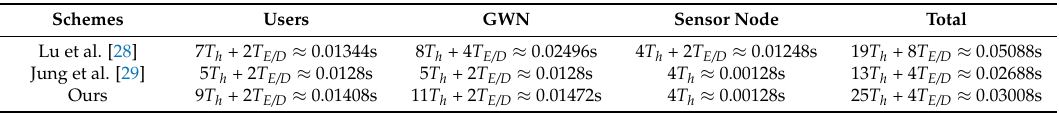
Table 3. Computation complexity comparisons of our scheme and the two related